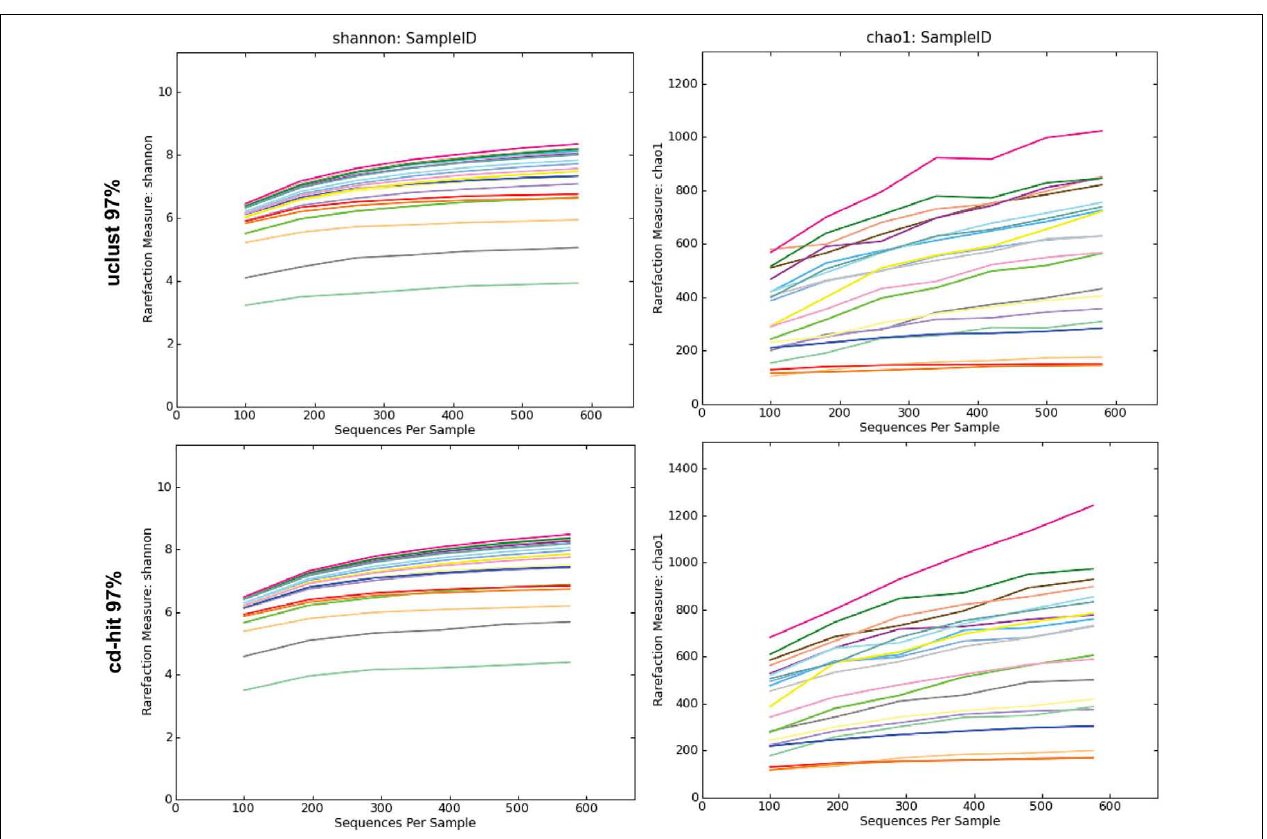
curves show that the alpha diversity of a majority of the samples approaches an asymptote, and there is a wide range in the alpha diversity of the samples.